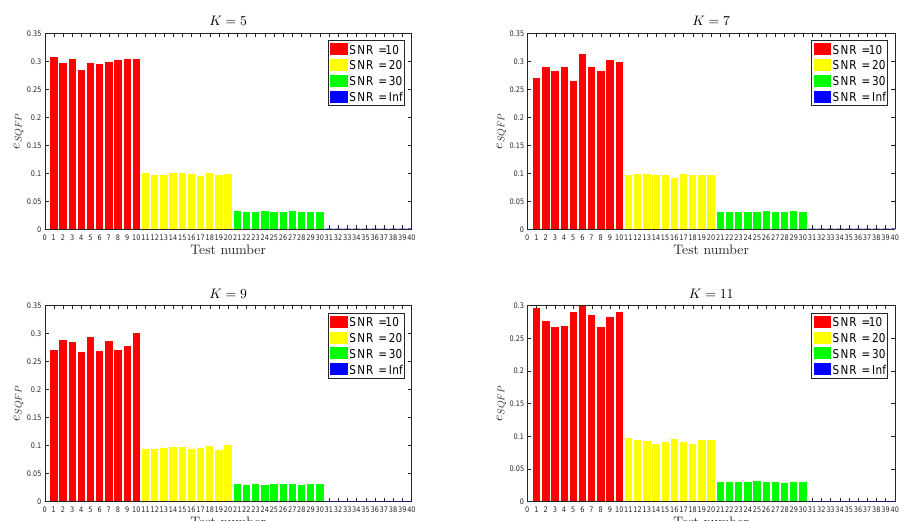
Figure 2. Relative errors for Sparse Quadratic Feasibility Pump (SQFP) for matrix conditioning of 10,000.